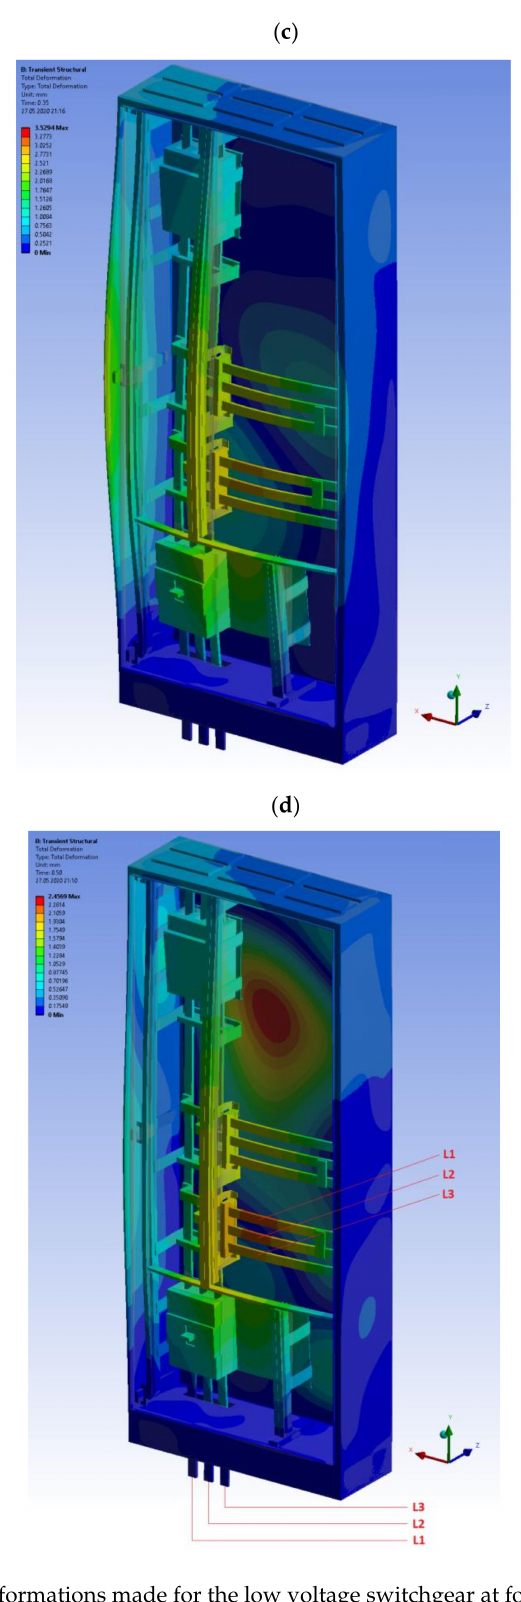
Figure 15. Results of deformations made for the low voltage switchgear at four di ff erent short circuit times: ( a ) T = 0.21 s; ( b ) T = 0.28 s; ( c ) T = 0.35 s; ( d ) T = 0.5